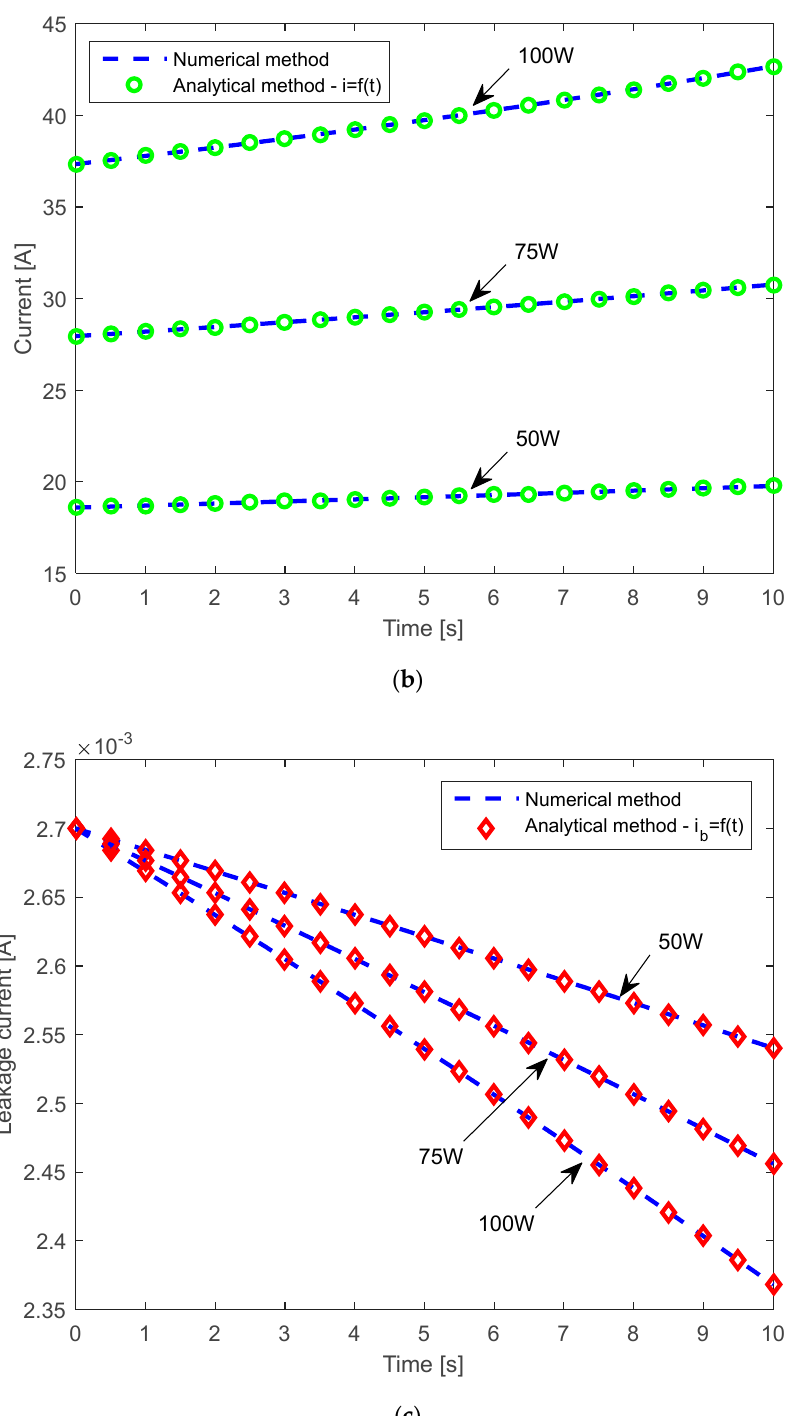
Figure 8. Discharging mode characteristics at different power values: ( a ) voltage versus time; ( b ) current versus time; ( c ) leakage current versus time; C = 1200 F, R b = 1000 Ω , and R = 0.58 m Ω .